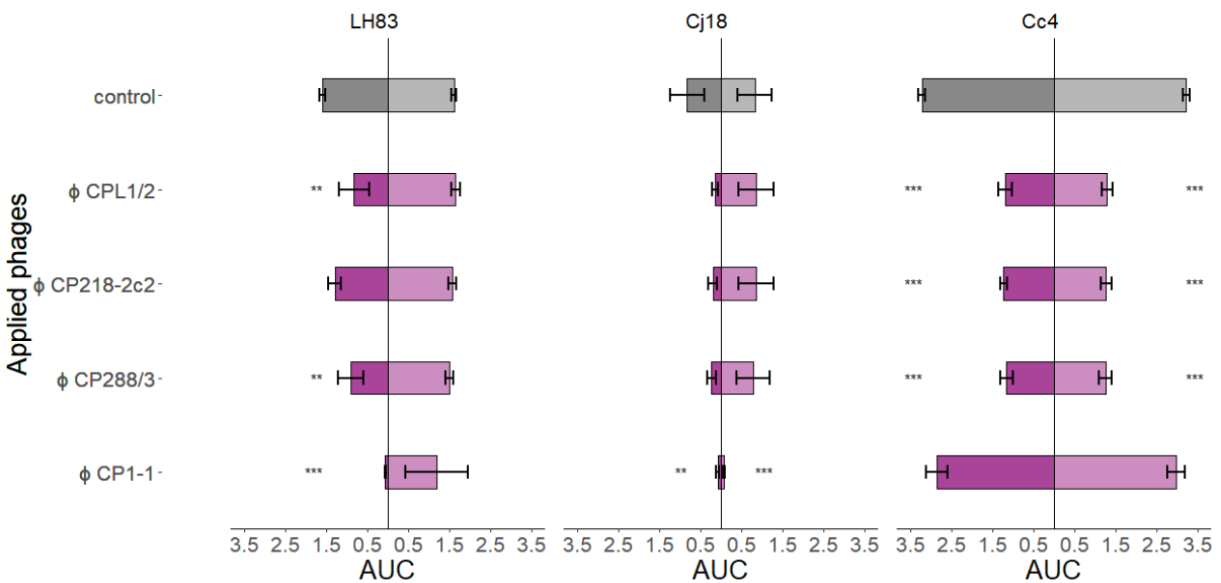
Figure 4. Area under the curve (AUC) values from planktonic killing assays for single-phage applications on three different Campylobacter strains. C. jejuni LH83, Cj18, and C. coli Cc4 were exposed to three group II phages (CPL1/2, CP218-2c2, and CP288/3) or one group III phage (CP1-1) in single-phage planktonic killing assay at an MOI input 10 ( (cid:4) / (cid:4) ) or MOI input 0.001 ( (cid:4) / (cid:4) ).